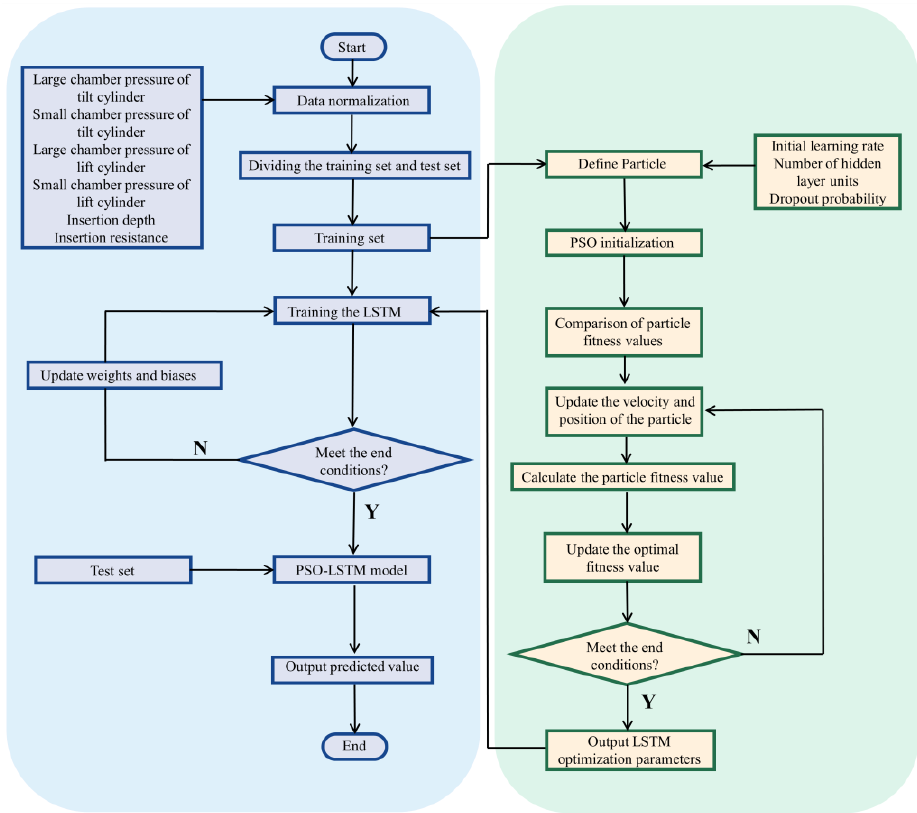
Figure 16. PSO-LSTM optimization process. Table 3. Initial parameters of PSO.